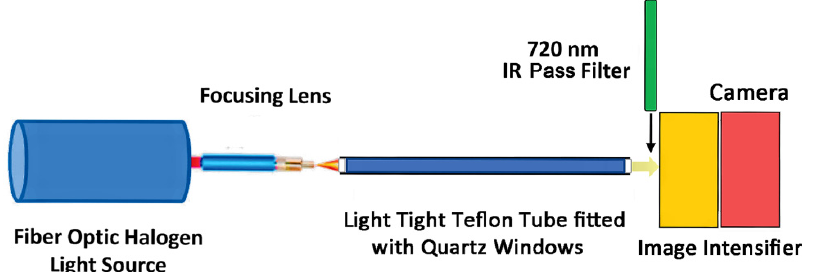
Figure 5. Experimental setup for measuring light